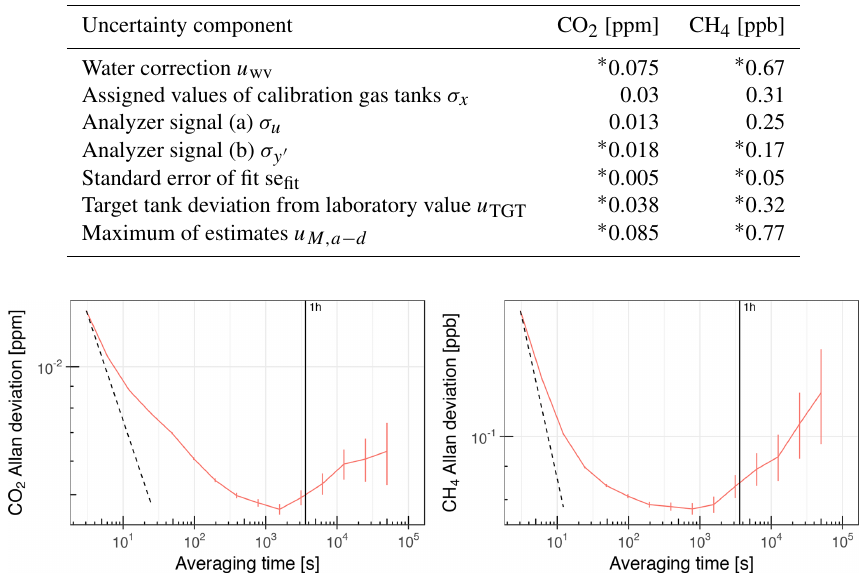
Figure E2. Allan deviation of the CO 2 and CH 4 readings of the CRDS analyzer in Ambarchik. Values are based on one 12d measurement of dry air from a gas tank in the lab prior to field deployment. The averaging time is cut off where the error becomes too large for a meaningful interpretation of the result. The vertical line denotes an averaging time of 1h. The dashed line corresponds to white noise (slope − 0 . 5), scaled to coincide with the first data point of the Allan